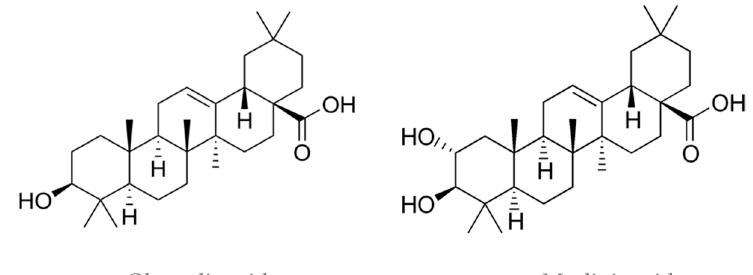
Figure 4. Structures of oleanolic and maslinic acids.